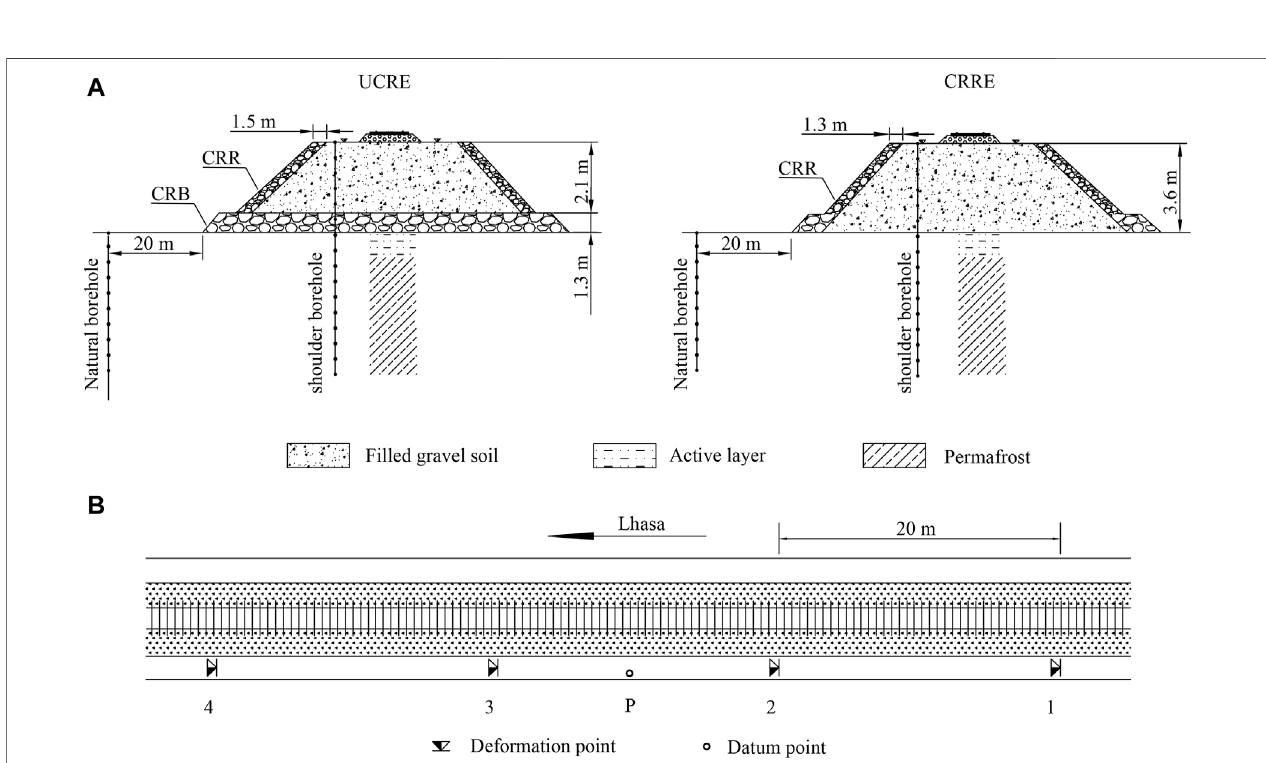
FIGURE 2 | Monitoring system of the sections. The distribution of ground temperatures boreholes (A) and the distribution of deformation monitoring points (B) .